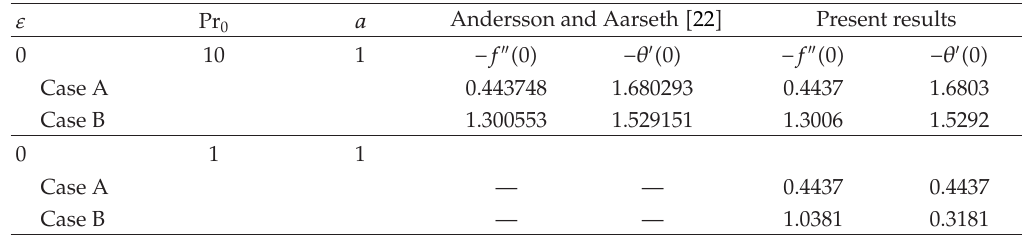
Table 2: Values of the reduced skin friction f (cid:4)(cid:4) (cid:5) 0 (cid:6) and reduced heat flux at the moving surface for Pr 0 (cid:8) 1 , Pr 0 (cid:8) 10, and a (cid:8) 1 in both Cases A and